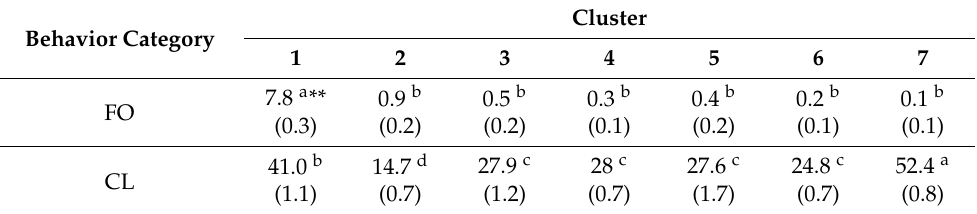
Figure 5. Differences in behavioral patterns under different experimental conditions on a self-organizing map. Apple snails were evaluated using four different conditions of changing water temperatures from 25 °C to ( a ) 15 °C; ( b ) 20 °C; ( c ) 25 °C (control); and ( d ) 30 °C. All behavioral categories (except SW and FA) were significantly different among the clusters (Table 2). FO (7.8%) was the highest in cluster 1 whereas CS were the lowest in cluster 1 (12.0%) and cluster 4 (13.3%). CB and CS were highest in cluster 2 (35.6%) and cluster 6 (37.7%), respectively. FF was highest in cluster 5 (7.6%) and VE (8.3%) was high in cluster 3. CL was the highest in cluster 7 (52.4%) whereas crawling on the bottom of the aquarium (14.1%) and feeding behavior (18.3%) were the lowest. Table 2. Differences among nine behavioral categories in different clusters trained in the self-organizing map. FO: floating; CL: clinging to the side of the aquarium; CB: crawling on the bottom of the aquarium; CS: crawling on the side of the aquarium; FE: feeding on lettuce; FF: folding a funnel with its food; SW: swimming; VE: ventilating the lung; and FA: falling.